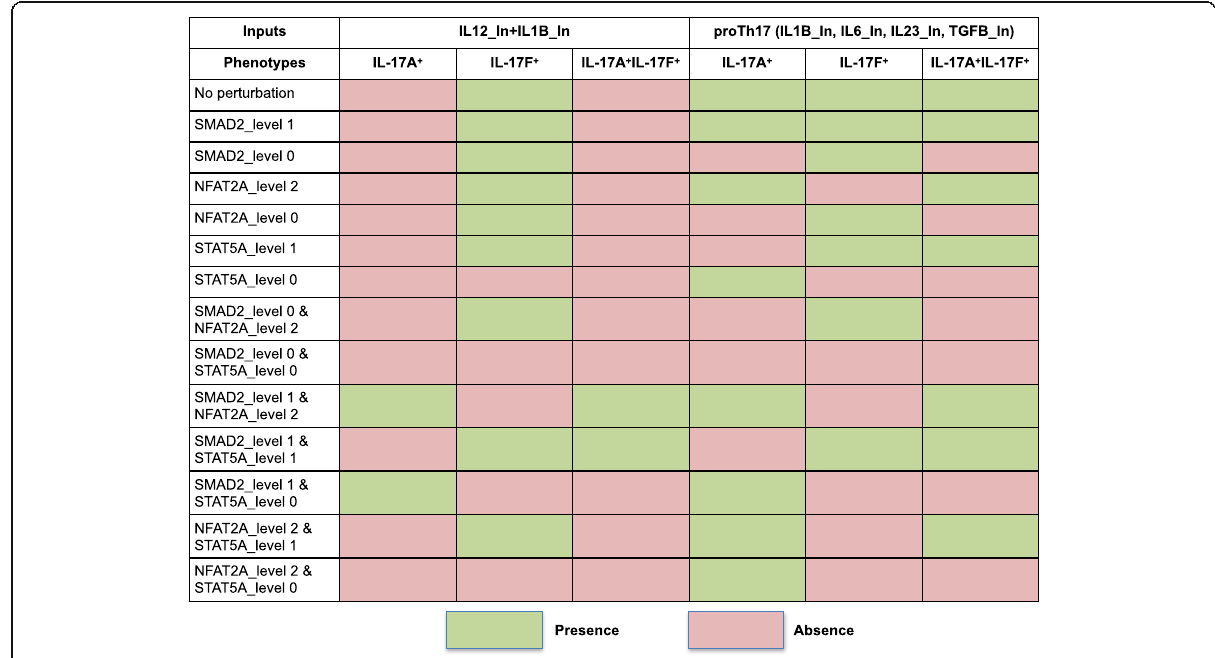
Fig. 6 Computational perturbations point to model internal components controlling IL-17A activation. The schema summarizes the impact of selected perturbations (knock-in or knock-out) on IL-12 + IL-1 β and Th17 differentiation. Rows denote single or multiple perturbations of SMAD2, STAT5A and NFAT2A. Green and red cells represent activated and inactivated phenotypes,